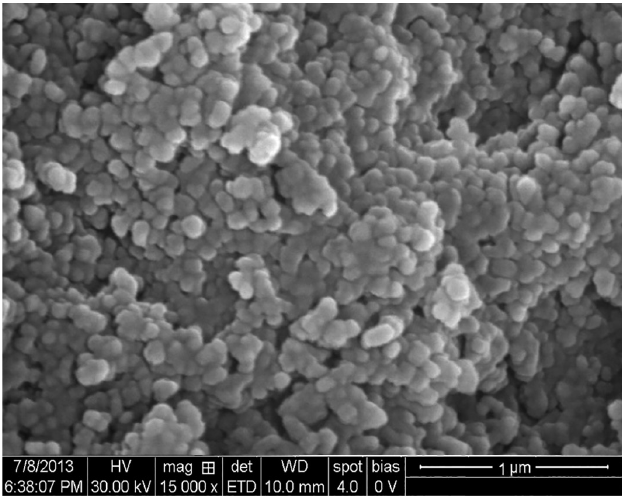
FIGURE 4 - SEM photograph of lenalidomide -PLGA-NPs .